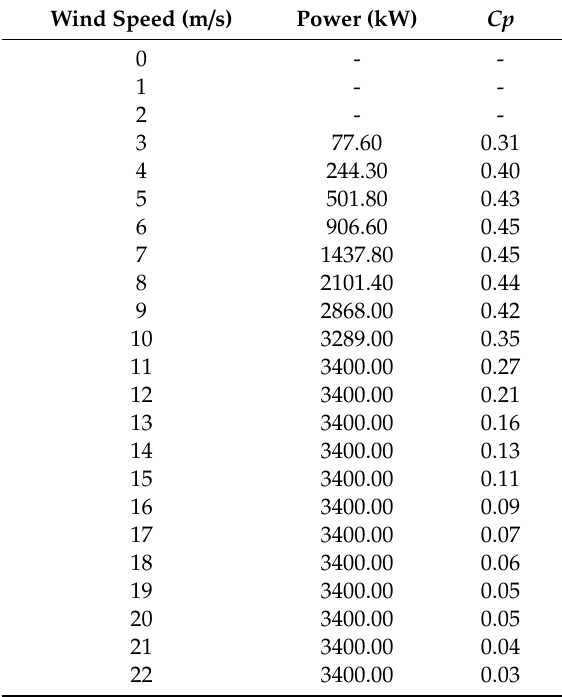
Table 7. Wind turbine power